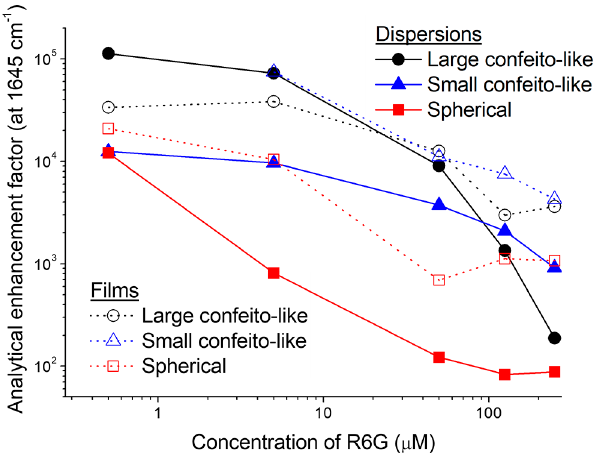
Figure 5. Analytical enhancement factors of Raman scattering (1645 cm − 1 ) of R6G at various concentrations in the dispersions and on the films of AuNPs. The open-marks and dotted-lines represent the films, while closed-marks and solid-lines are for the dispersions.